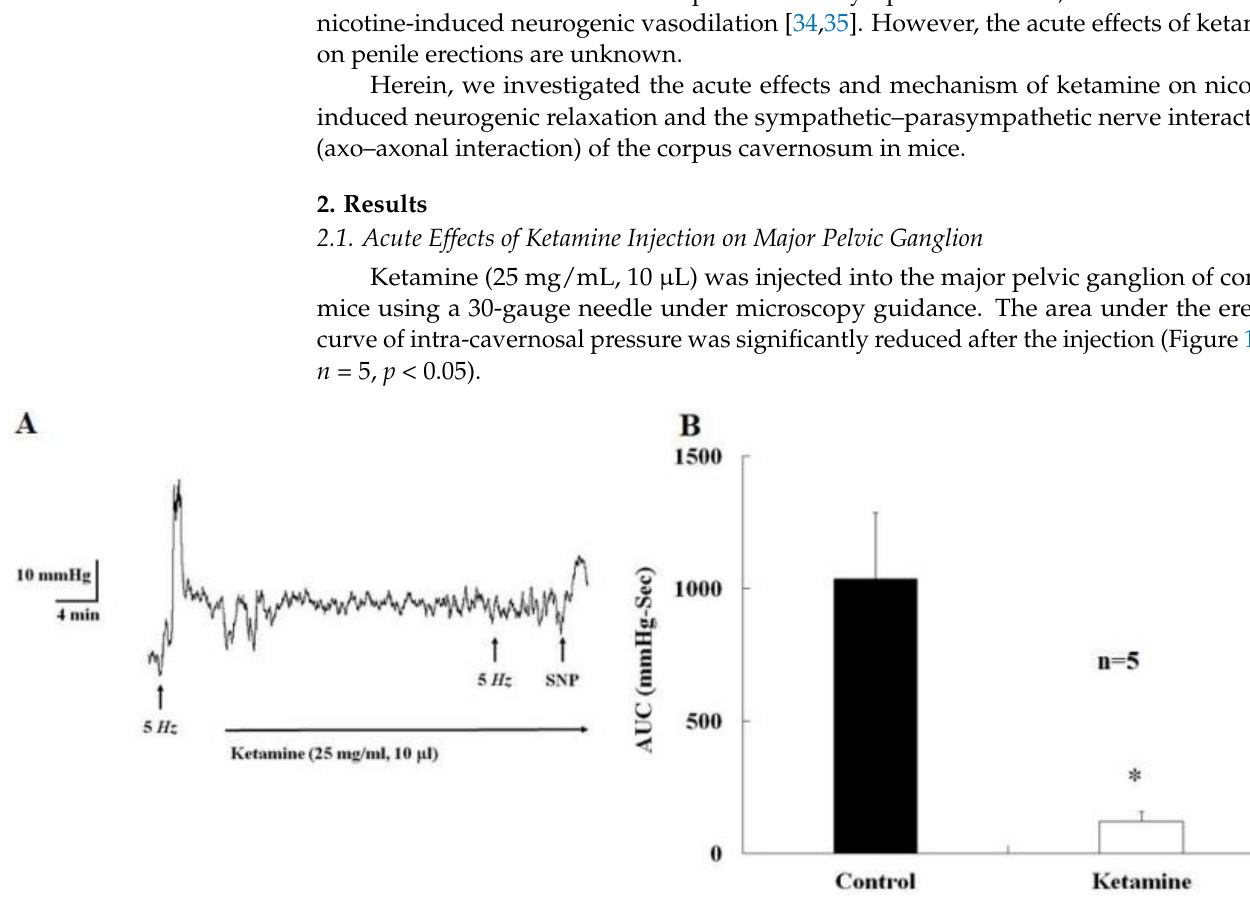
Figure 1. Acute effects of ketamine on the electrical stimulation after major pelvic ganglia injection. The representative tracing depicts activation of the major pelvic ganglia (MPG) by electrical stimulation (5 Hz) in male control mice. This increase in intra-cavernosal pressure (ICP) was abolished by ketamine injection into MPG ( A ) and partly reversed by sodium nitroprusside (SNP, 0.1 mM/5 µ L) application. The decrease in ICP by ketamine ( n = 5) injection reaches a statistical difference ( B ). Values are means ± SD. The asterisk indicates a significant difference in the paired t -test (* p < 0.05) vs. the control group.